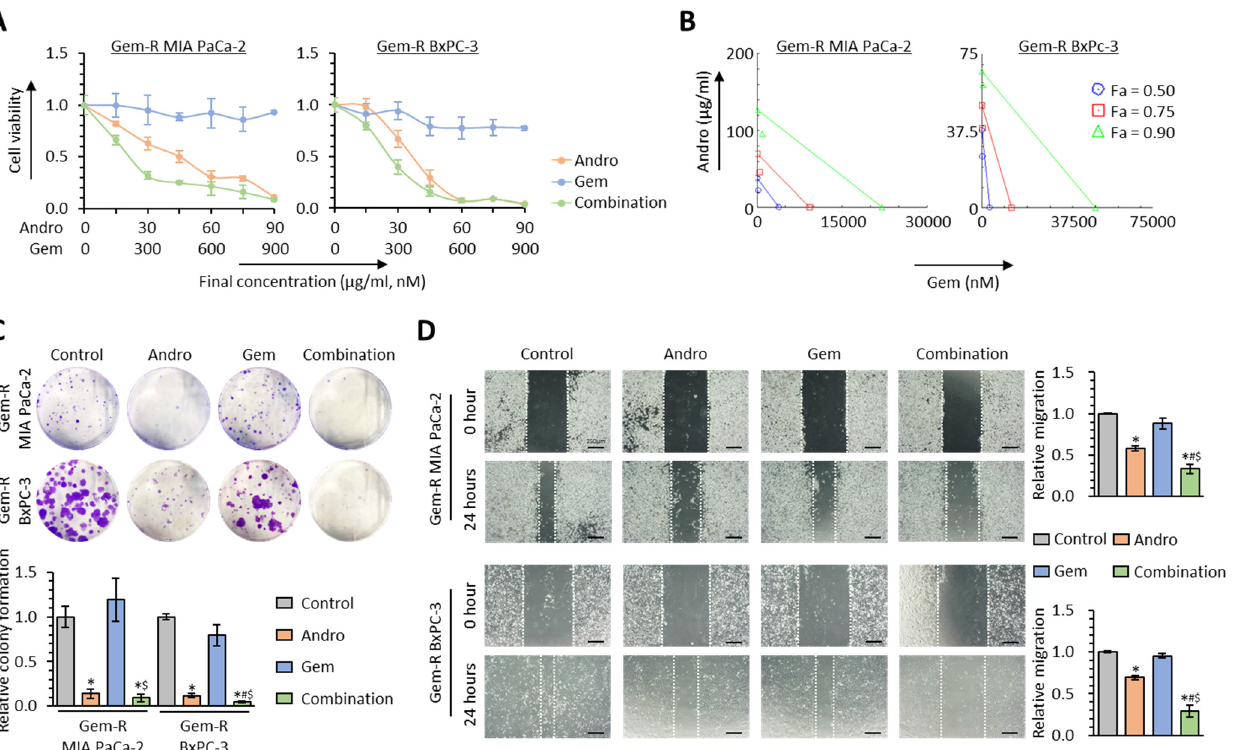
Figure 3. Andrographis potentiates the chemosensitivity to Gemcitabine in resistant PDAC cells. ( A ) Cell viability assays following treatment with Andro, Gem, and their combination for 48 h in Gem- R MIA PaCa-2 and BxPC-3. Error bars are the mean ± SD. ( B ) Isobologram analyses after combined treatment with Andro and Gem in Gem-R MIA PaCa-2 and BxPC-3. ( C ) Colony formation assays to evaluate clonogenicity of Gem-R PDAC cells following treatment with Andro, Gem, and their combination. The average (column) ± SD is indicated (* p < 0.05 vs. control, # p < 0.05 vs. Andro, $ p < 0.05 vs. Gem). ( D ) Wound healing assay following treatment with Andro, Gem, and their combination for 24 h in Gem-R PDAC cells. Photographs show representative scratched and wound- recovering areas (marked by white lines). Scale bar = 250 µ m. The average (column) ± SD is indicated (* p < 0.05 vs. control, # p < 0.05 vs. Andro, $ p < 0.05 vs. Gem). PDAC, pancreatic ductal adenocarcinoma; Gem-R, Gemcitabine-resistant; Andro, Andrographis; Gem, Gemcitabine; SD, standard